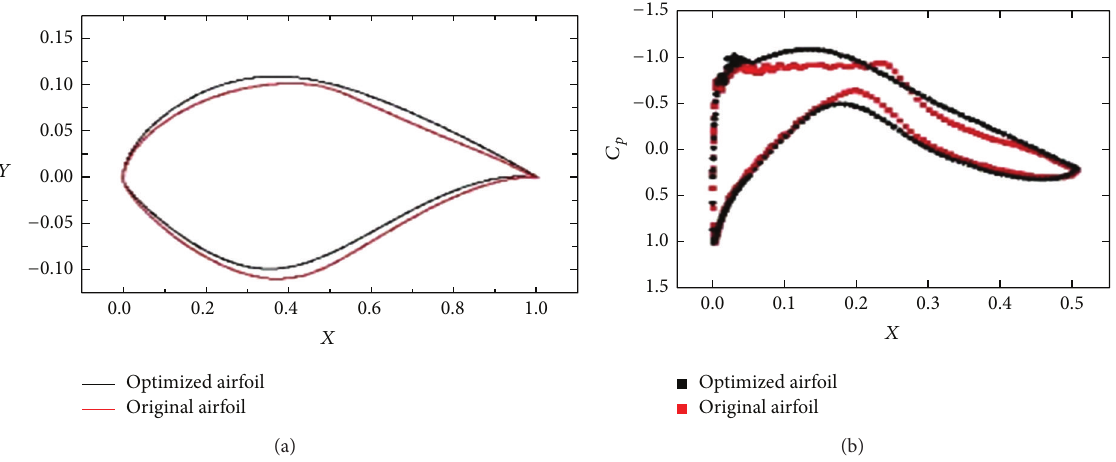
Figure 13: Comparison of original airfoil and optimized airfoil (98% span): (a) shape and (b) pressure distribution.